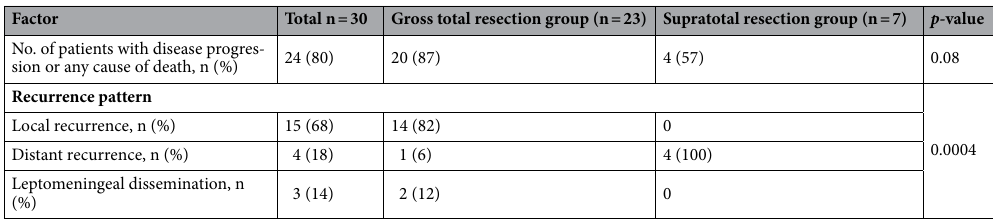
Table 2. Disease control and recurrence